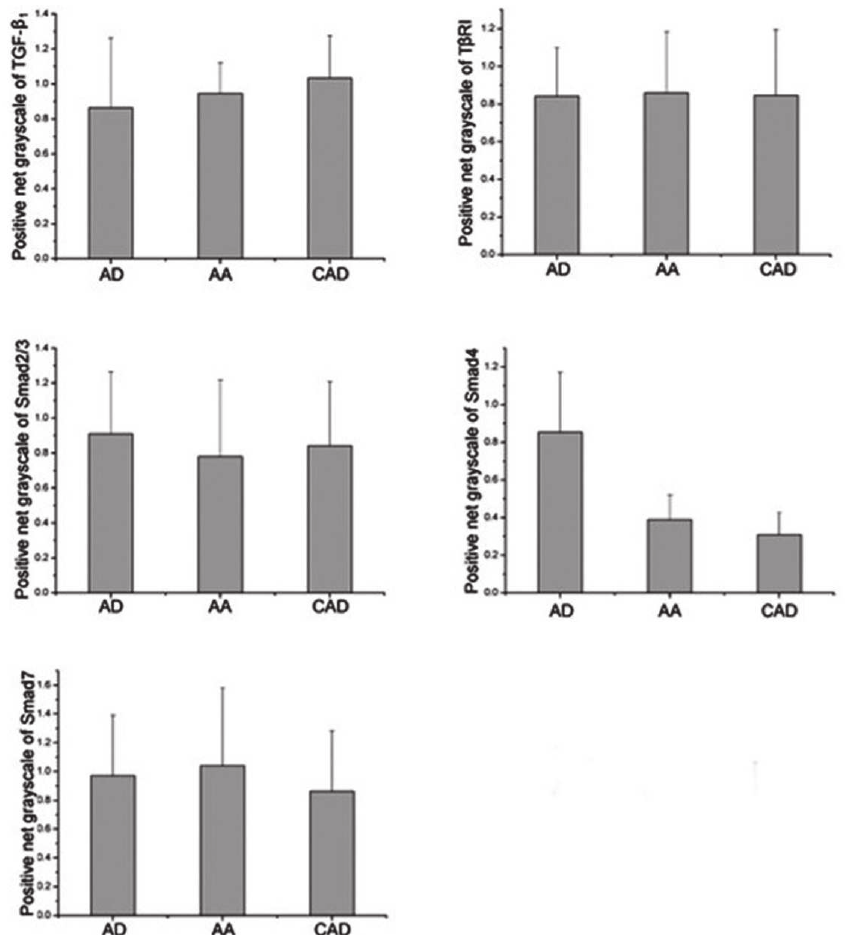
Fig. 3. Relative positive net grayscales of TGF-ß expression of TGF-ß was lower in aortic dissection 1